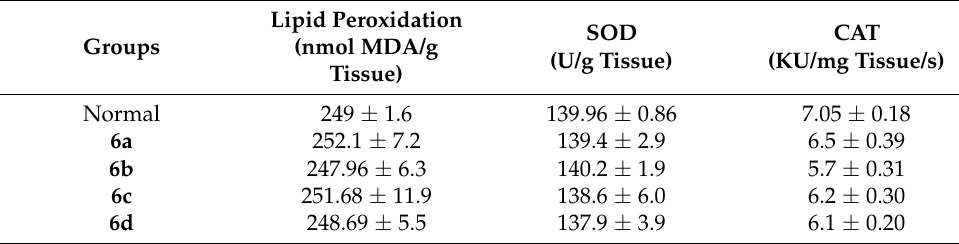
Table 4. Effect of tested indoloquinoline derivatives on lipid peroxidation and antioxidant enzymes in normal